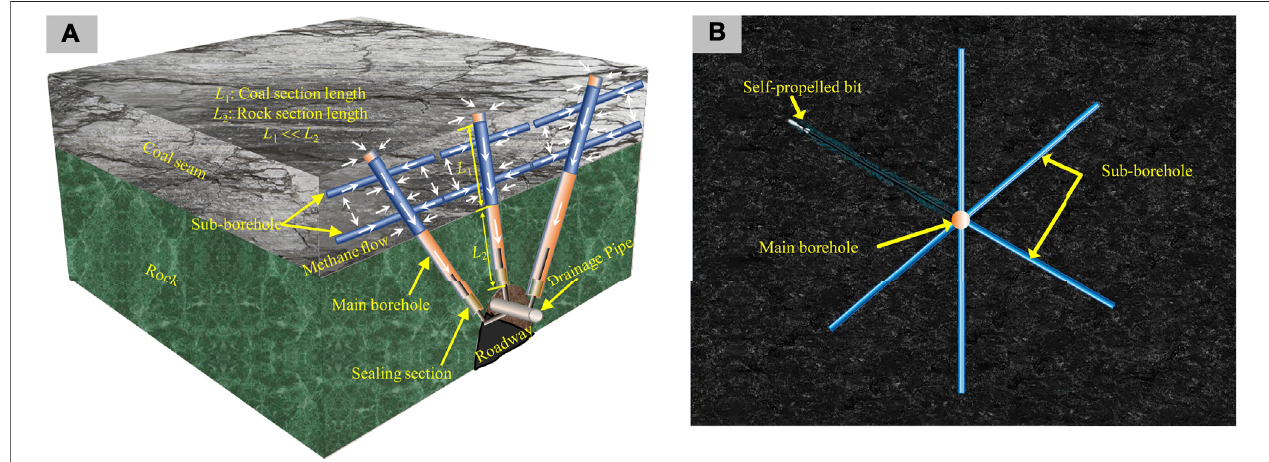
FIGURE 1 | Illustrations showing tree-type borehole drainage technique. (A) Block diagram; (B) Plan view of a single